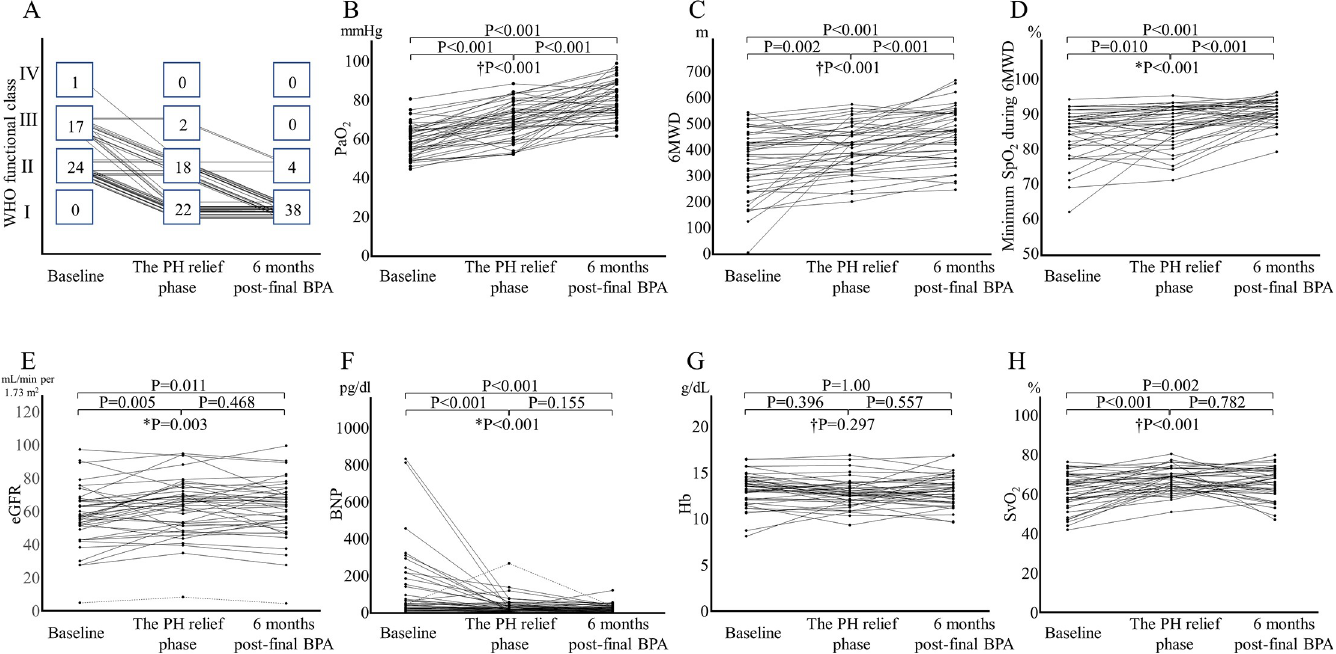
Fig 4. Changes in oxygenation, exercise capacity, and laboratory data. (A) World Health Organization (WHO) functional class. (B) The partial pressure of oxygen (PaO 2 ). (C) The 6-minute walk distance (6MWD) test. (D) Minimum oxygen saturation (SpO 2 ) during the 6MWD test. (E) Estimated glomerular filtration rate (eGFR). (F) Brain natriuretic peptide (BNP). (G) Hemoglobin (Hb) level. (H) Mixed venous oxygen saturation (SvO 2 ). The pulmonary hypertension (PH) relief phase was the first time a mean pulmonary artery pressure � 25 mmHg or pulmonary vascular resistance � 240 dyn-s/cm 5 was reached before each subsequent balloon pulmonary angioplasty (BPA) session. � P-value of Friedman’s test. †P-value for repeated-measures analysis of variance.